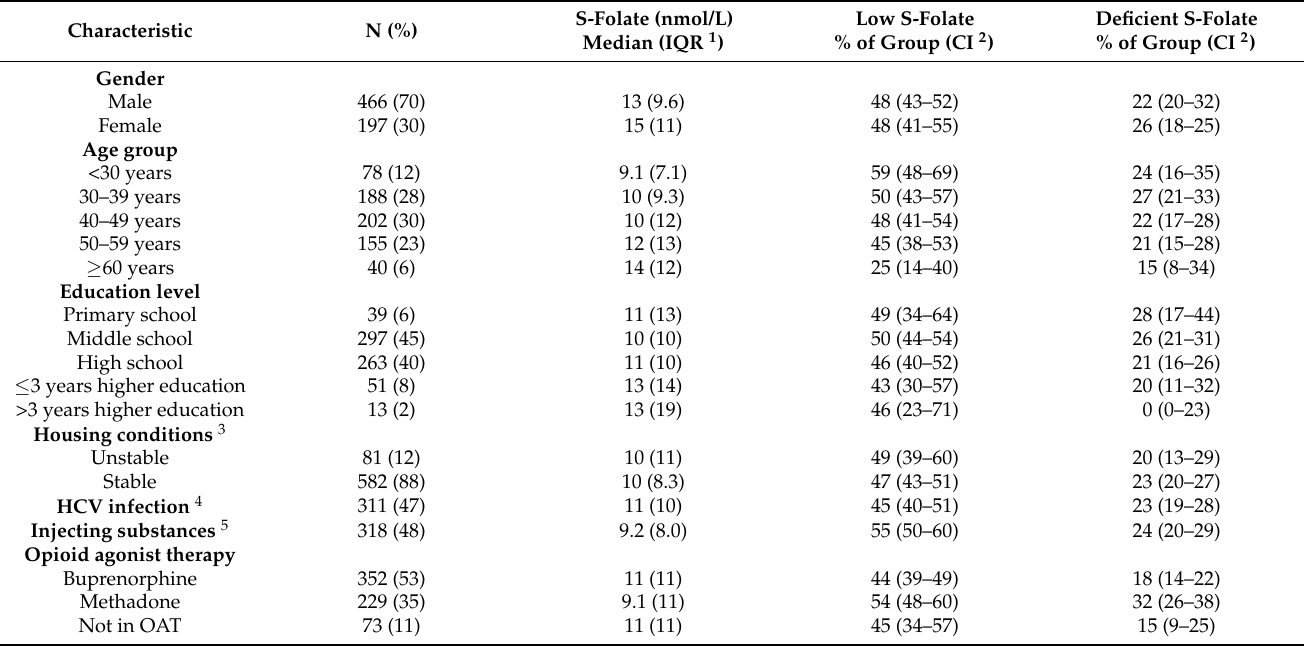
Table 1. Descriptive characteristics of the study population, median serum folate and the prevalence of inadequate folate status and folate deficiency at